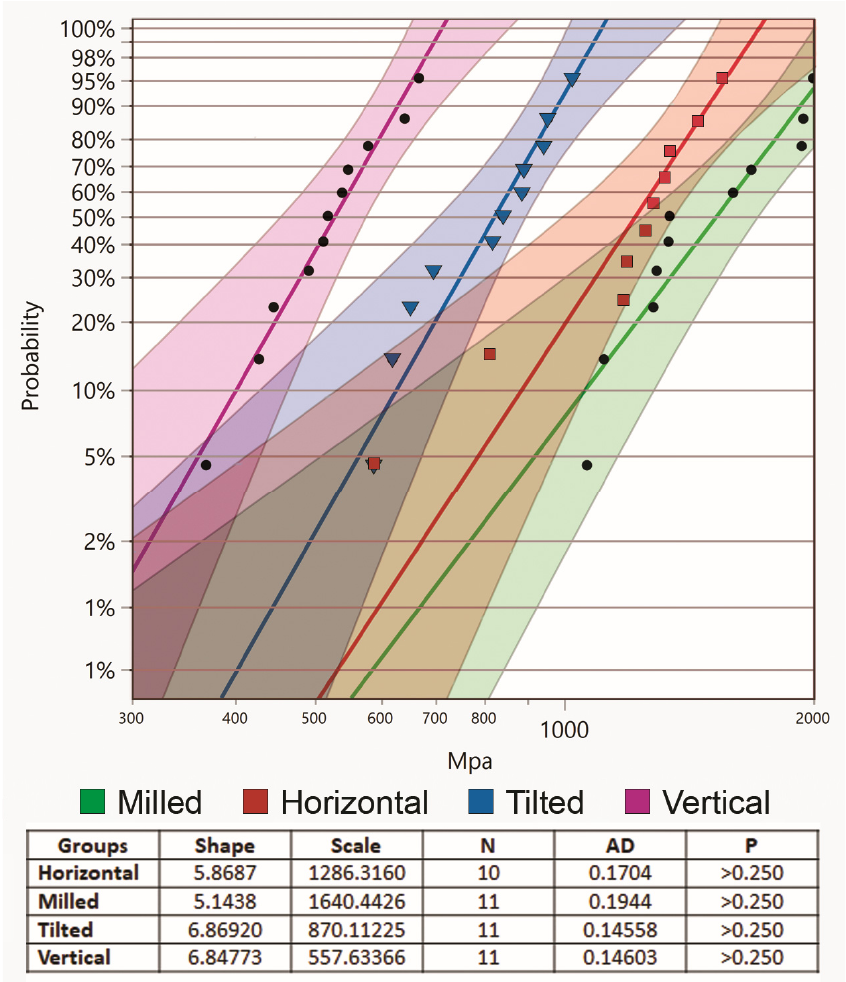
Figure 5. Weibull